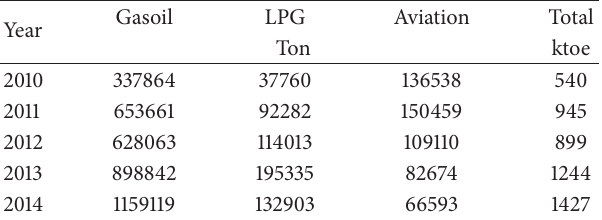
Table 13: Fuel import (ton/year)